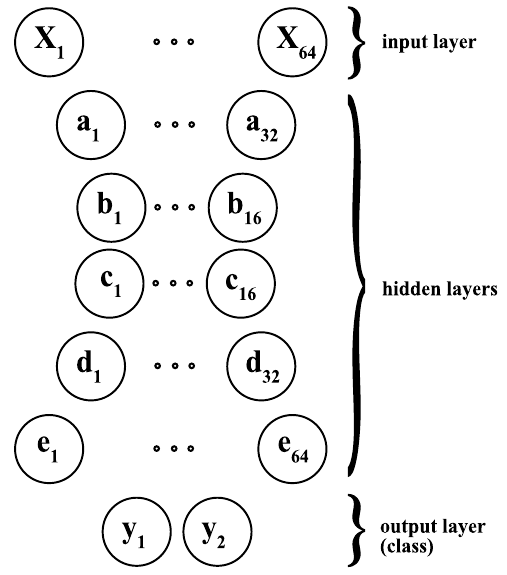
Figure 6. Implemented Autoencoder classifier